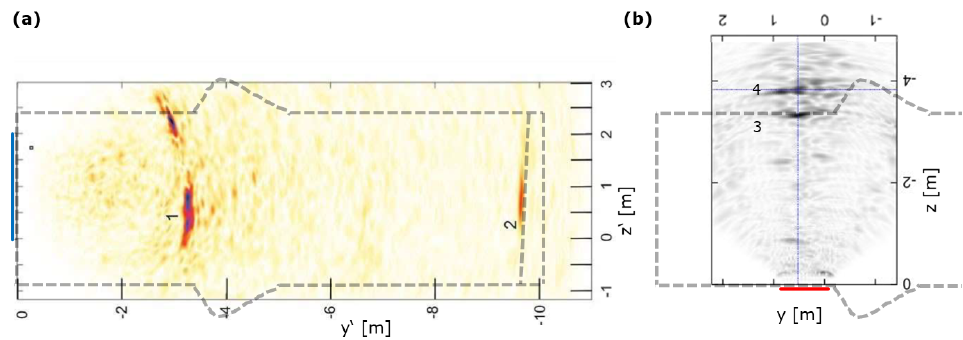
Figure 5. LAUS GV2 ultrasonic images (after [16]) and comparison to engineered barrier (grey dashed line, details in Figure 3a): ( a ) Ultrasonic imaging from the front (LAUS area 1, blue), results from [16] and ( b ) ultrasonic imaging from the side (LAUS area 2, red), equivalent to Figure